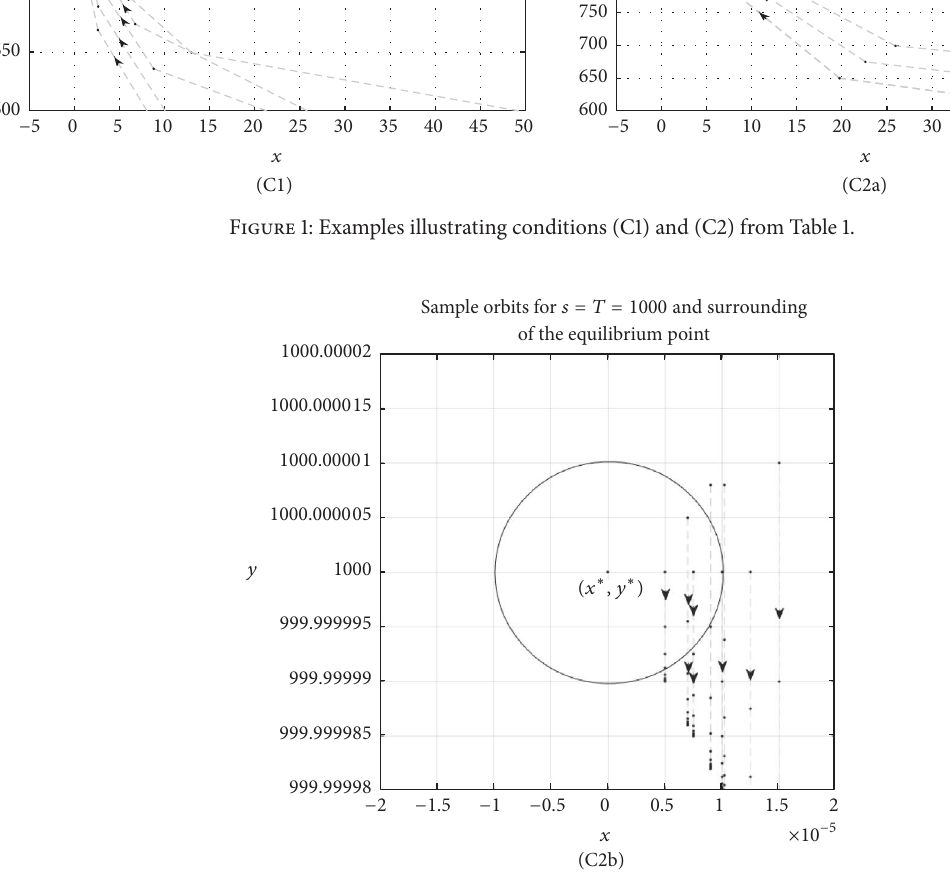
Figure 2: Example illustrating condition (C2) from Table 1.